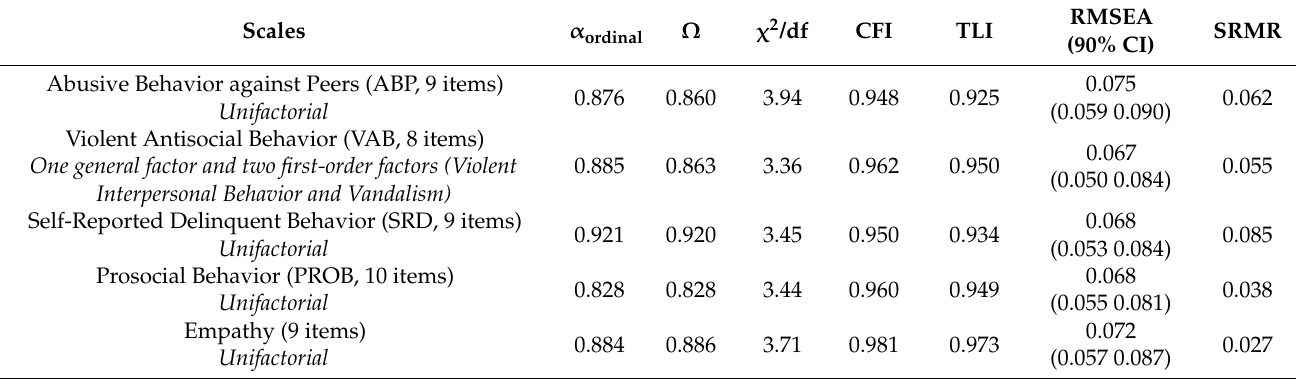
Table 3. Evidence of reliability and fit of the factor structures of the constructs correlated with the